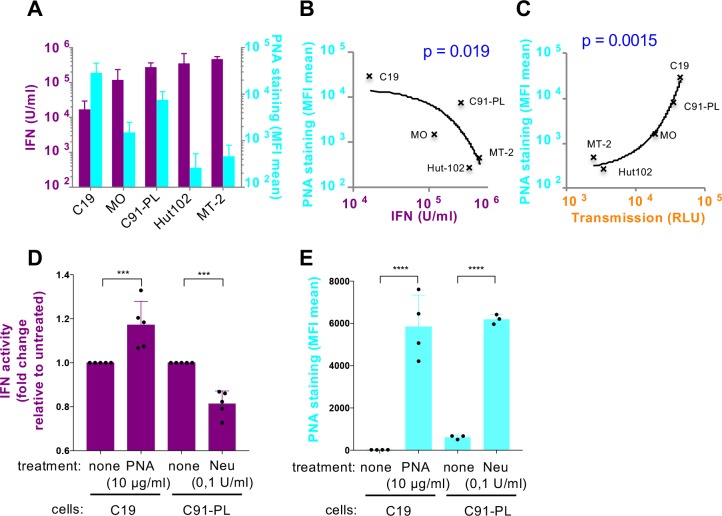
The differential surface glycan composition of HTLV-infected cells regulates the levels of pDC IFN-I production A.Parallel representation of the maximum levels of IFN-I production induced after co-culture of pDCs with HTLV-1-infected cells and the amount of surface PNA binding on HTLV-2 (C19 and MO) infected cell lines and HTLV-1 (C91-PL; Hut102 and MT-2) infected cell lines (mean ± SD; 5 independent experiments). B-C. Regression correlation curve of the amount of PNA binding at the surface of HTLV-infected cells and the maximum IFN-I production induced by the HTLV-infected cells (B) or the level of infectious viral transmission to naïve reported Jurkat LTR-Luc cells (C). Computes correlation p-values calculated with Spearman test are indicated. D. Quantification of IFN-I production by pDCs co-cultured with C19 or C91-PL infected cells treated or not with PNA (10 μg/ml) for 30 minutes or with neuraminidase (Neu, 0.1 U/ml) for 1h prior the co-culture, as indicated. Results are presented as fold changes relative to untreated cells (mean ± SD, 5 independent experiments). Asterisks indicate statistically significant differences calculated using unpaired t-test between treated versus untreated setting: *** p<0.001. E. FACS analysis of C19 stained or not with PNA (10μg/ml) and C91-PL infected cells treated or not with neuraminidase (Neu, 0.1 U/ml) for 1h before staining with PNA (mean ± SD; 4 and 3 independent experiments respectively). Asterisks indicate statistically significant differences calculated using paired t-test between treated versus untreated setting: **** p<0.0001.